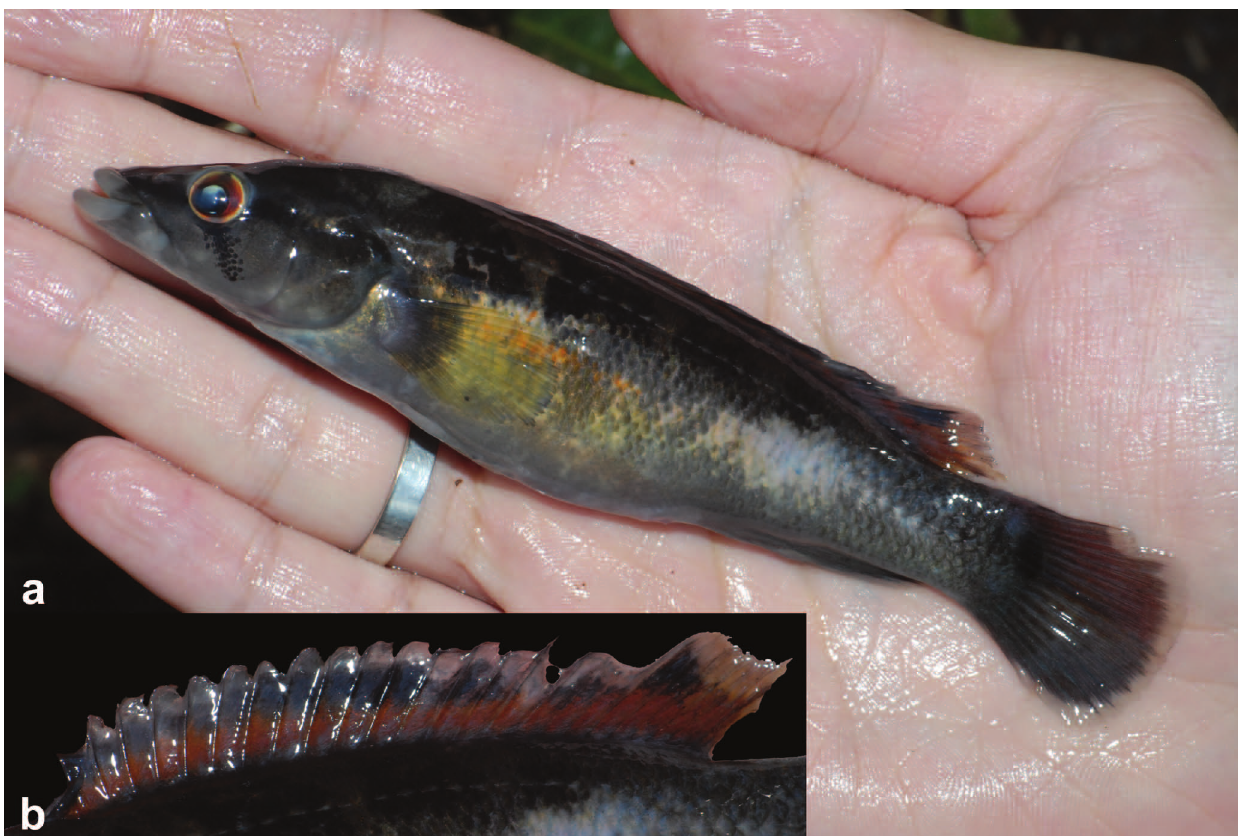
Fig. 3. Crenicichla ypo , MACN-ict 9438, 104.0 mm SL, female, paratype: a ) a freshly collected specimen damaged from gillnets; b ) detail of the dorsal fin showing the diagnostic black-red stripe pattern of females.